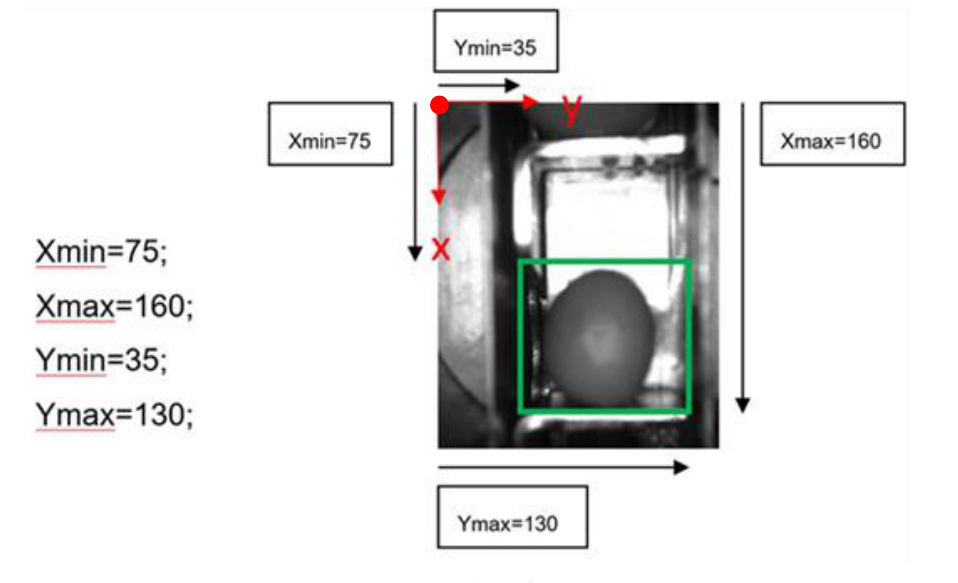
Figure 3. Selected ROI.